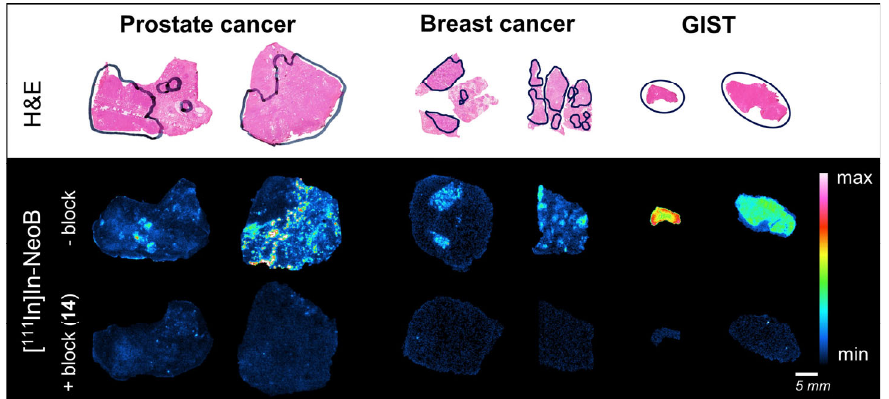
Figure 6. Hematoxylin-eosin staining ( top row ) and ex vivo autoradiography of human prostate cancer, breast cancer and gastro-intestinal stromal tumor (GIST) sections from six representative patients demonstrating binding of [ 111 In]In-NeoB in the absence ( − block; middle row ) or presence (+ block ( 14 ); bottom row ) of an excess of 14 . Tumor regions were circled in black by experienced pathologists.